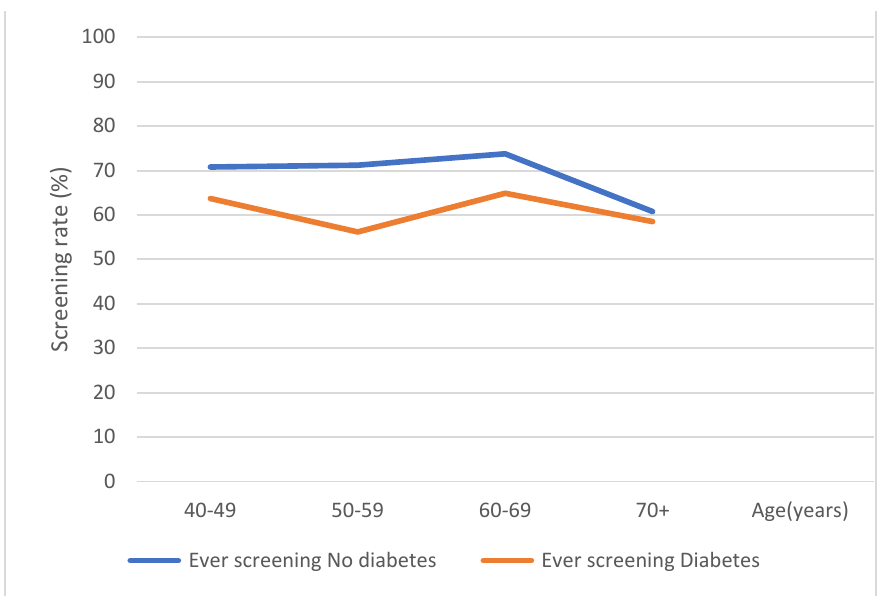
Figure 3. Ever gastric cancer screening rate according to diabetes status and age.